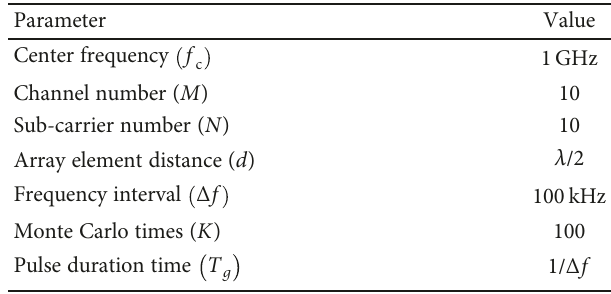
Table 1: Simulation parameters of joint estimation on range and angle in high